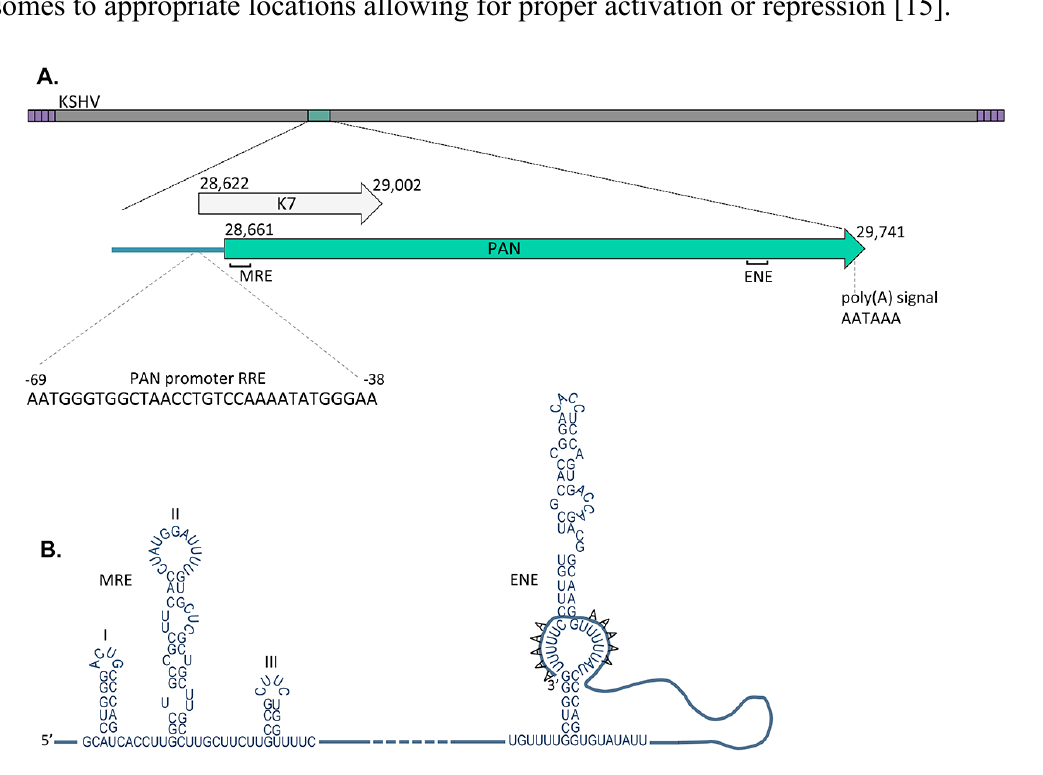
Figure 1. Schematic diagram depicting key features of the PAN locus and transcript. ( A ) The nucleotide numbering for the K7 ORF and PAN transcript corresponds to genbank accession number U75698.1 for HHV8/KSHV genome type M isolated from BC-1 cells. The numbering for the RRE within the PAN promoter and the ENE is from the transcription start site; ( B ) The secondary structure of the ENE and MRE sequence within PAN RNA to prevent degradation and increase